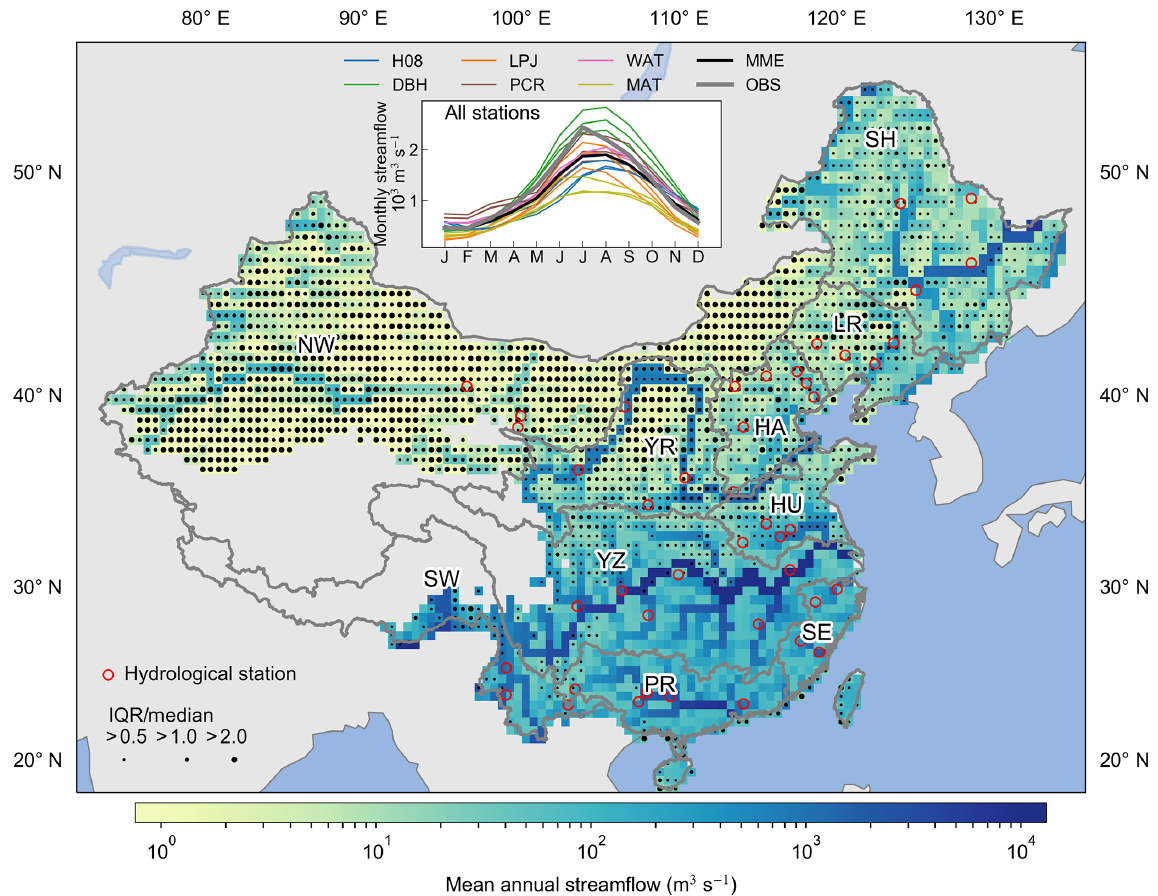
Figure 1. Multimodel medians of mean annual streamflow (MAF) in China from the VARSOC experiment. MAF medians are computed across 18 GHM–GMF combinations over the 1971–2000 period. The ensemble spread is represented by the ratio of interquartile range (IQR; 75th percentile minus 25th percentile) to the ensemble median of MAF (median). The hydrological stations used in this study are identified by red circles. The inner plot shows the comparison of the simulated seasonal streamflow (each GHM has three lines for the three GMFs) from the VARSOC experiment against the observations averaged for all the hydrological stations shown on the map over the period 1971–2000. H08, DBH, LPJ, PCR, WAT, and MAT denote the H08, DBH, LPJmL, PCR-GLOBWB, WaterGAP2, and MATSIRO models, respectively. MME denotes the multimodel ensemble median, and OBS denotes observation. The Tibetan Plateau region is masked by removing the grid cells with an altitude higher than 4000m, and the same applies in subsequent figures. The 10 major basins in China are labeled and are indicated with grey lines. The southern basins include the Yangtze River (YZ), southwestern rivers (SW), southeastern rivers (SE), and Pearl River (PR), the northern basins include the Songhua River (SH), Liao River (LR), northwestern rivers (NW), Hai River (HA), Yellow River (YR), and Huai River